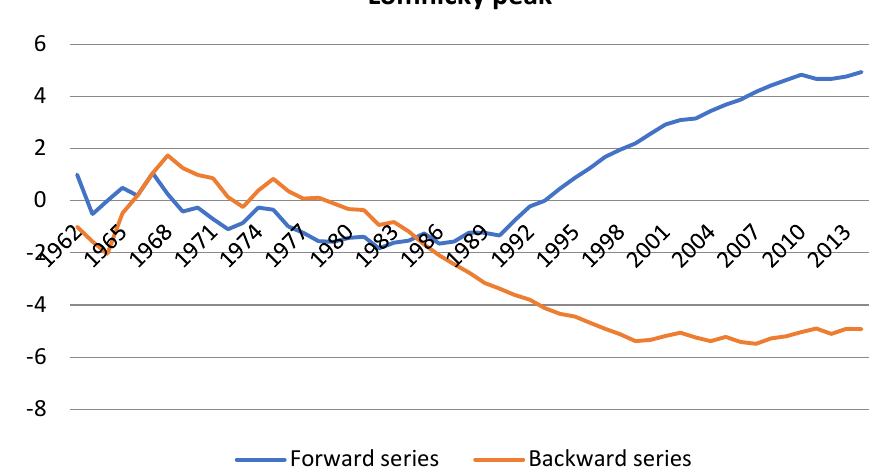
Figure 7. Forward and backward series of the SQMK test on the precipitation data series.